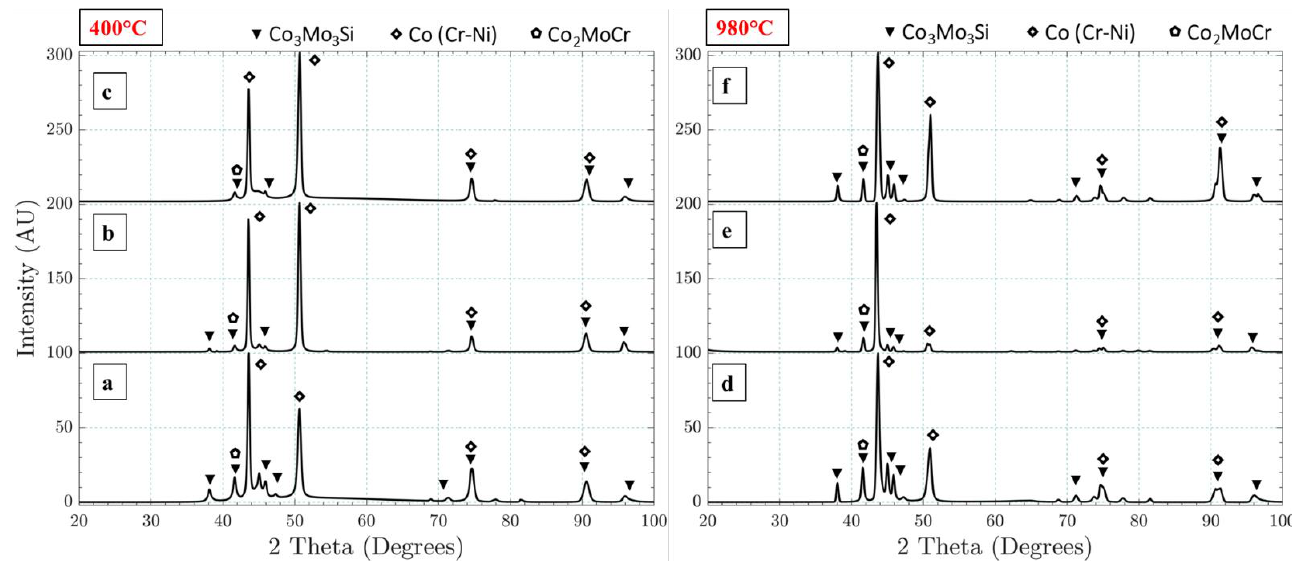
Figure 7. XRD results of samples heat treated at 400 °C and 980 °C. ( a , d ) T800 + 20% NiCr, ( b , e ) T800 + 30% NiCr, and ( c , f ) T800 + 40% NiCr.